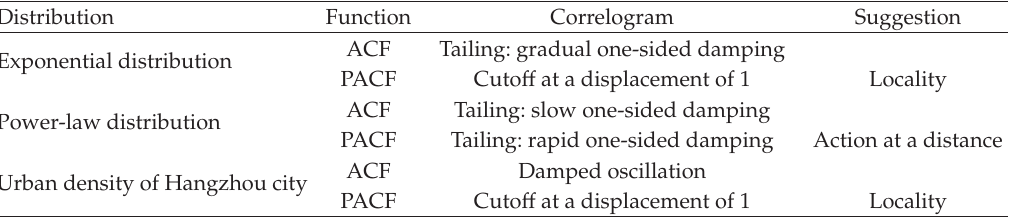
Table 4: Autocorrelation function (cid:6) ACF (cid:7) and partial autocorrelation function (cid:6) PACF (cid:7) values.